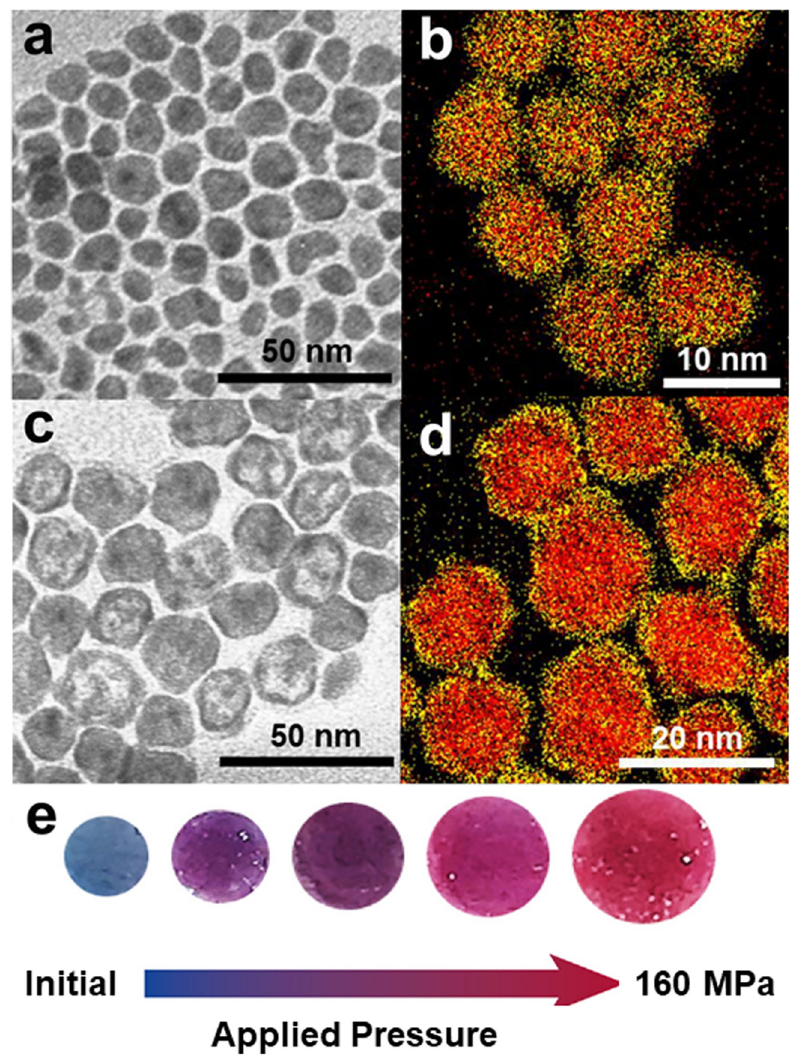
Figure 4: ( a – d ) TEM images and elemental spectra of Co – Pt NPs prepared with di ff erent Co/Pt precursor molar ratios; ( a and b ) Co:Pt = 60:40 and ( c and d ) Co:Pt = 70:30. Reproduced with permission [ 120 ] . Copyright 2020, American Chemical Society. ( e ) Appearance of the fi lms used under various pressures. Reproduced with permission [ 123 ] . Copyright 2019,